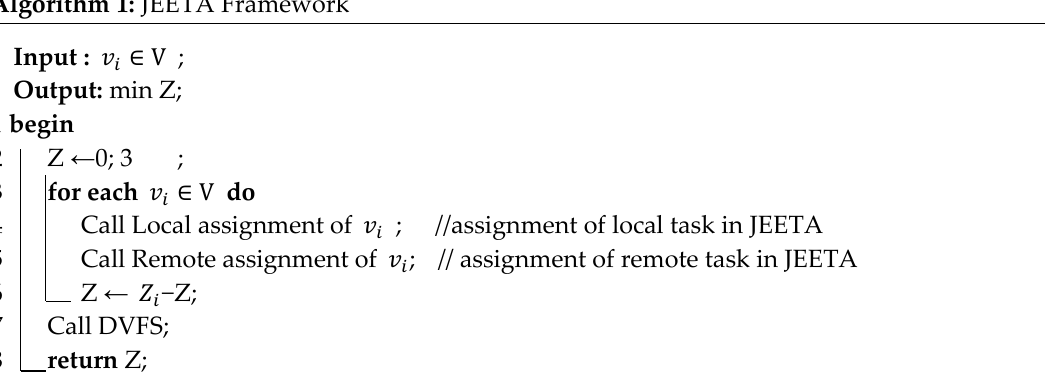
Algorithm 1: JEETA Framework